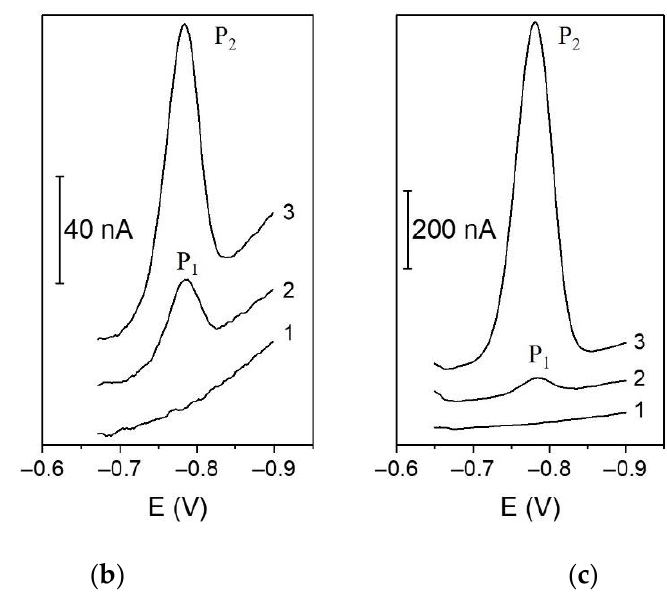
Figure 6. ( a ) CV voltammograms recorded for: (1) 0.1 M of KCl, 1 mM of DHB, 2 mM of EDTA and 10 nM of Ge(IV) (pH = 2.2) (1), (2) — as for (1), but with an additional 3mM of V(IV). Instrumental parameters: scan rate = 100 mVs − l , E acc = − 0.25 V, t acc = 30 s. Reprinted from [42] with permission from Elsevier. ( b ) DP voltammograms of (1) 0.05 M of acetate buffer and 20 nM of Ge, (2) — as for (1), but with the addition of 1.0 mM of catechol, (3) — as for (2), but with the addition of 1 mM of V(IV) and 1.5 mM of EDTA. Instrumental parameters: E acc = − 0.2 V, t acc = 80 s [40]. ( c ) DP voltammograms of (1) 0.05 M of acetate buffer and 20 nM of Ge, (2) — as for (1), but with the addition of 1.5 mM of catechol, (3) — as for (2), but with the addition of 1mM of V(IV) and 1.5 mM of HEDTA. Instrumental parameters: E acc = − 0.2 V, t acc = 80 s. Adapted with permission from ref. [40].